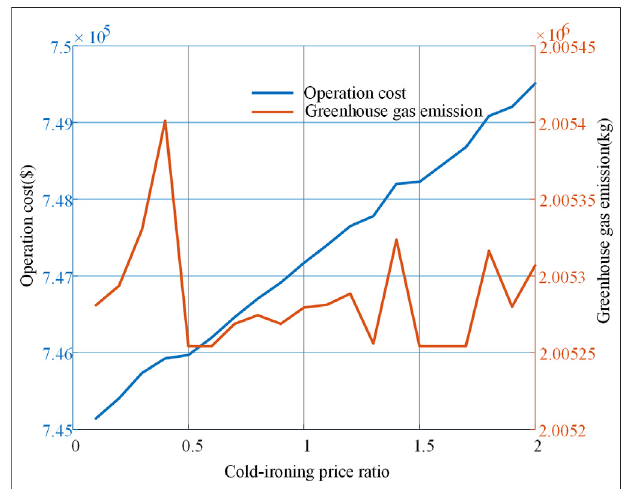
FIGURE 10 | Sensitivity analysis of weight for operation cost.